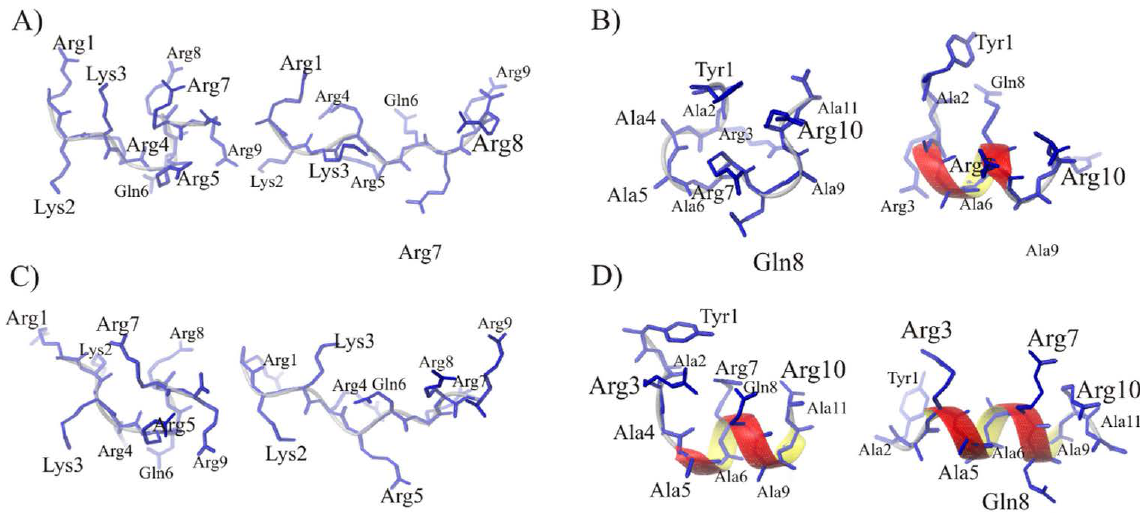
Figure 3. Spatial structures of the two most dominant clusters calculated for Tat(49–57)-NH 2 in water ( A ) and 30% TFE ( C ), and for PTD4 in water ( B ) and 30% TFE ( D ). On the left, cluster 1; on the right, cluster